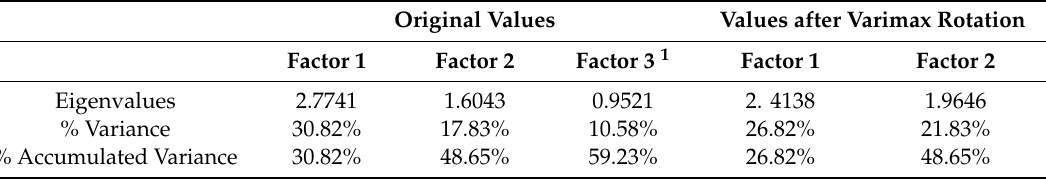
Table 8. Variance explained.